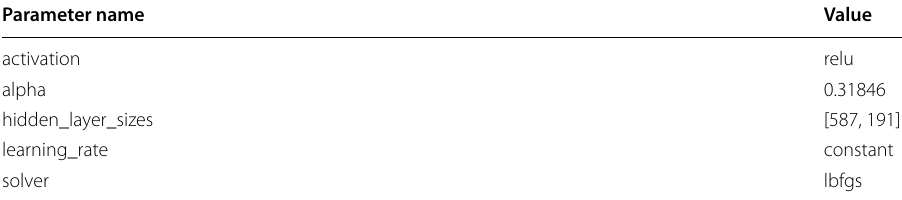
Table 82 Modes of MLP tuned hyperparameter values for experiments with the data exfiltration dataset